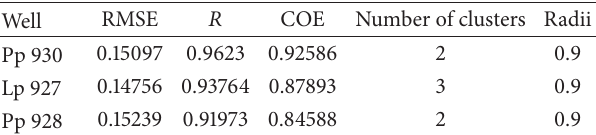
Table 5: ANFIS model performance criteria: root mean squared error (RMSE), coefficient of determination ( 𝑅 ), and coefficient of efficiency